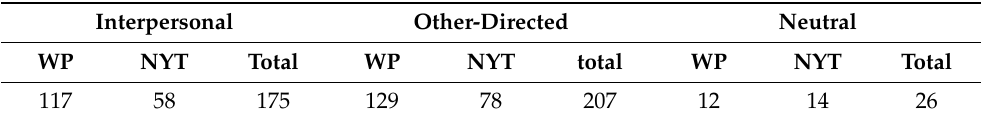
Table 4. Proportions of toxic comments divided up on what the comments are directed at: 1 is interpersonal 2 is directed at other (including public figures) and 3 is neutral.